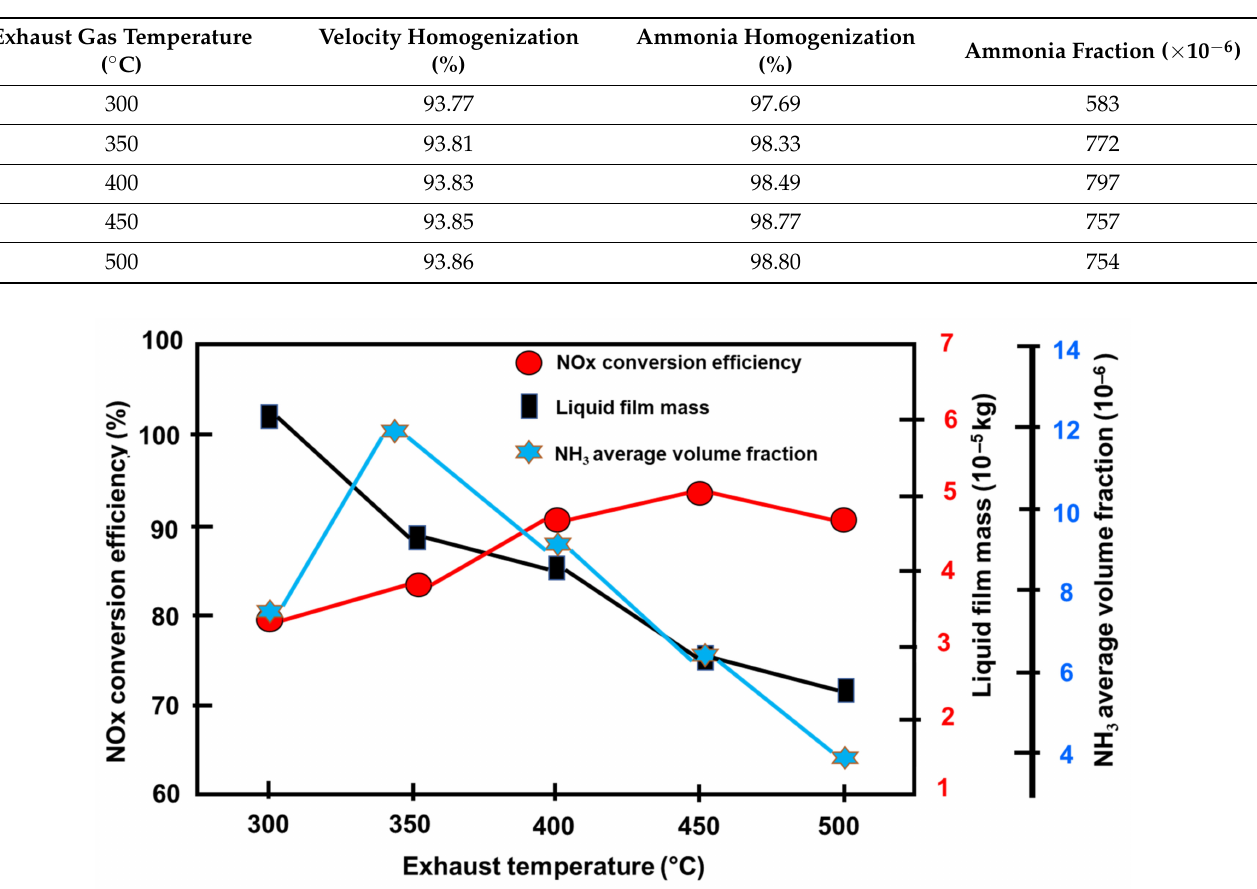
Figure 15. Performance at various exhaust temperatures